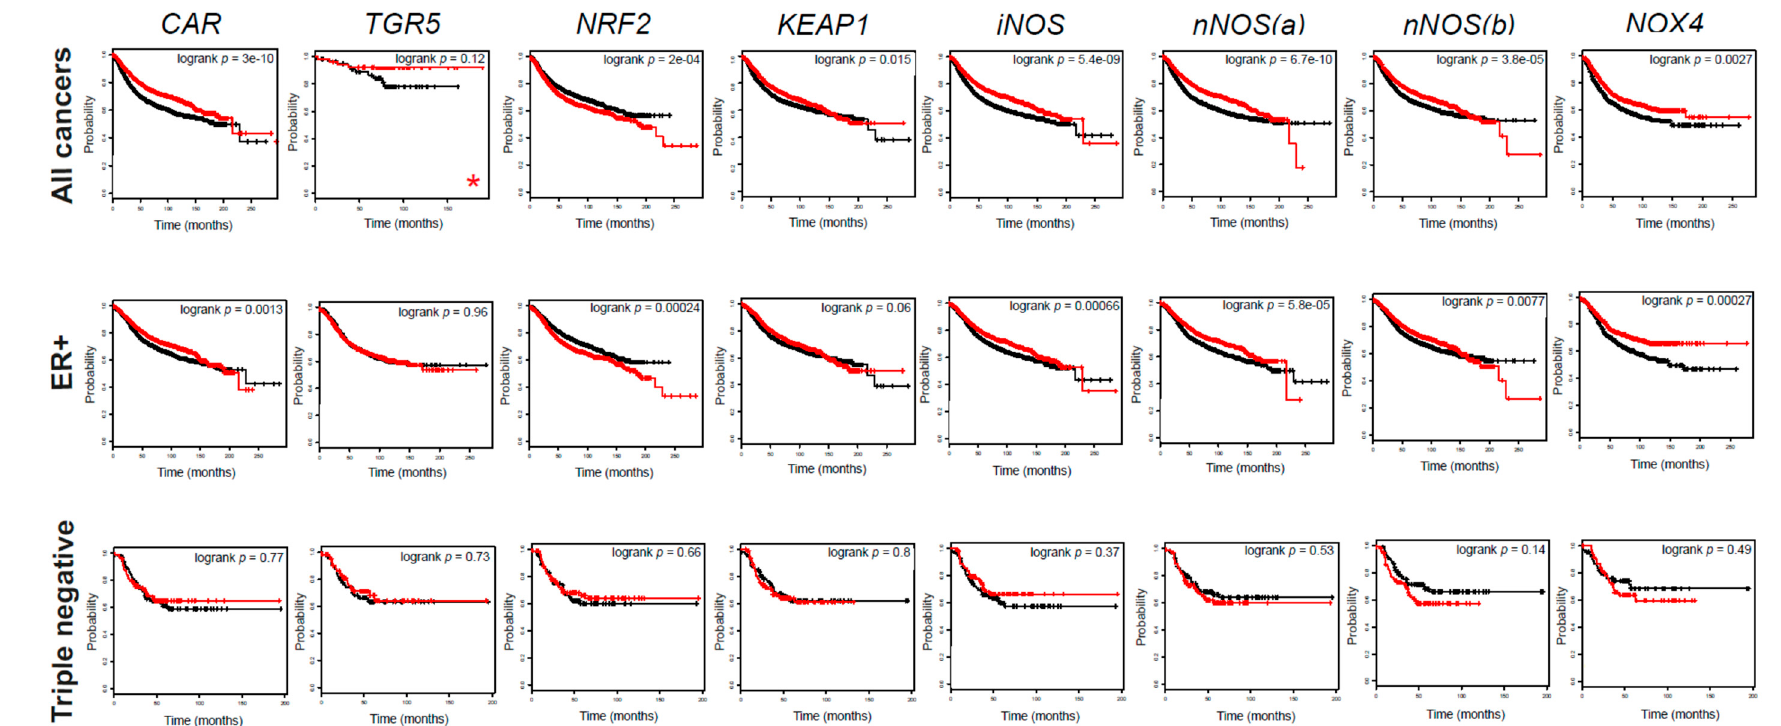
Figure 13. The components of the LCA–TGR / CAR pathway are protective in human breast cancer. The impact of CAR , TGR5 , NRF2 , KEAP1 , iNOS , nNOS , and NOX4 expression on survival in breast cancer patients was evaluated by assessing the kmplot.com database. All cancers, ER + , and triple negative cases were analyzed. The ER + population also included those patients where ER status was derived from gene expression data. Triple negative cases included patients with ER − status (including those patients where ER status was derived from gene expression data), PR − status, and HER2 − status. The red line indicates high expression while the black line indicates low expression. Probe IDs, numbers at risk, and hazard ratios are collected in Table 5. nNOS (a) represents 207309_at probe id, while nNOS (b) represents 207310_at probe set. * indicates that grade 1 patients are depicted. (CAR, constitutive androstane receptor; ER, estrogen receptor; KEAP1, Kelch-like ECH associating protein 1; NOX4, NADPH oxidase 4; NRF2, nuclear factor, erythroid 2-like 2; TGR5 / GPBAR1, G protein-coupled bile acid receptor 1 / Takeda G-protein coupled receptor; iNOS, inducible nitric oxide synthase; nNOS, neuronal nitric oxide synthase).